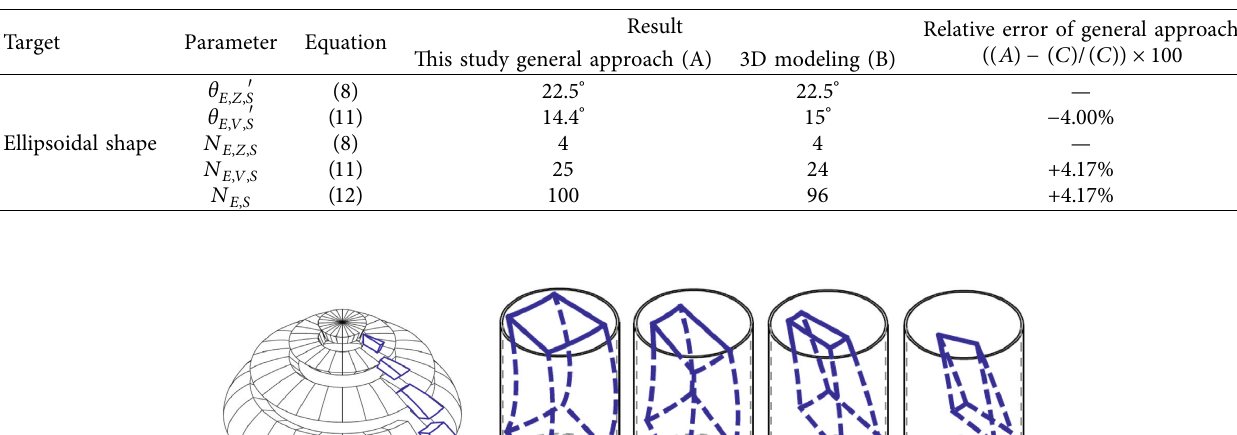
Figure 11: Comparison of geometry and dimensions of actual ellipsoidal-type bottom head (blue solid line) of VVER-1000 with hemispherical-type shape assumed in the study (red dotted line). Table 5: Segmentation strategy derived for an ellipsoidal-type bottom head of VVER 1000 RPV and comparison with the results from 3D modeling using Rhino.